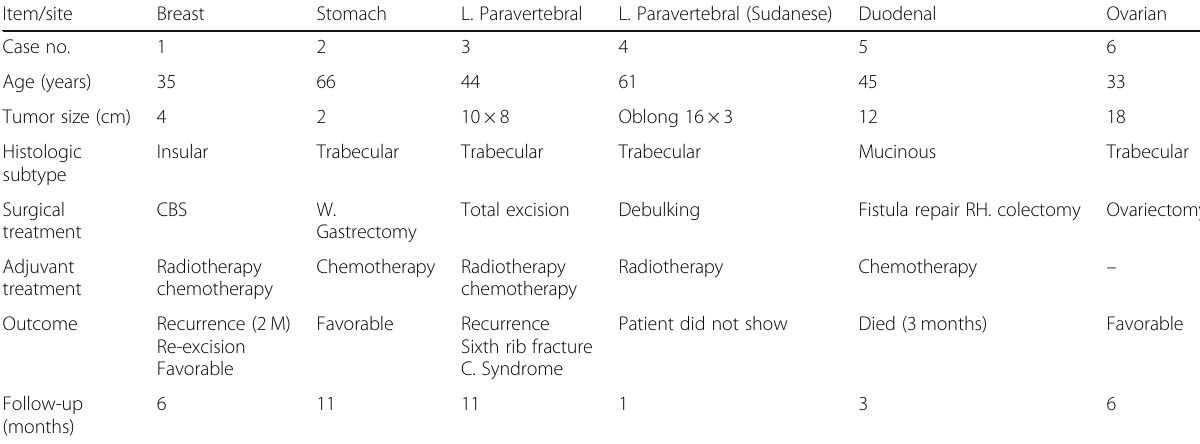
Table 1 Six carcinoid tumor cases at atypical sites. Clinicopathological characteristics, management, and outcome Item/site